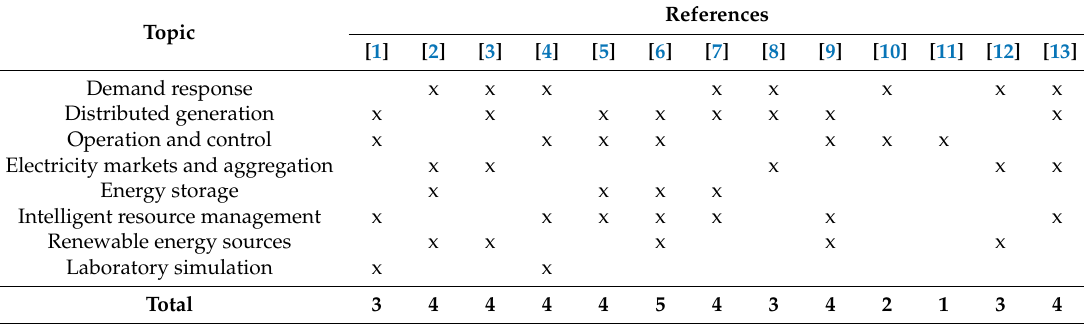
Table 1. Topics covered in each